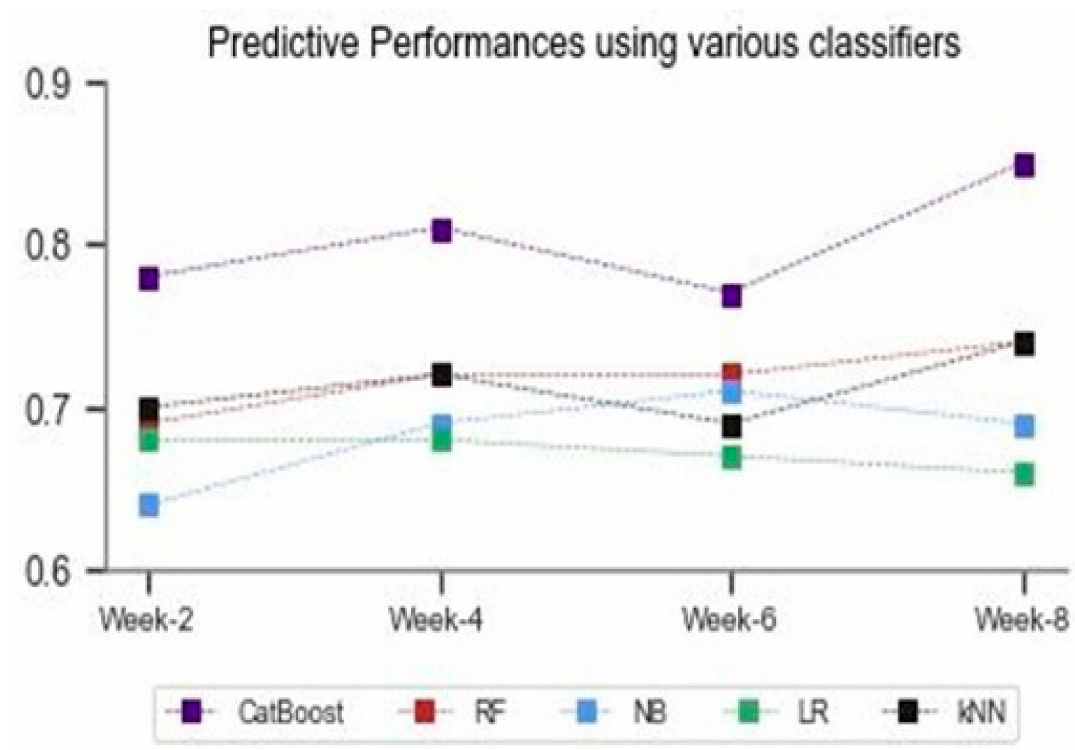
Figure 2. Predictive performances of various classifiers.